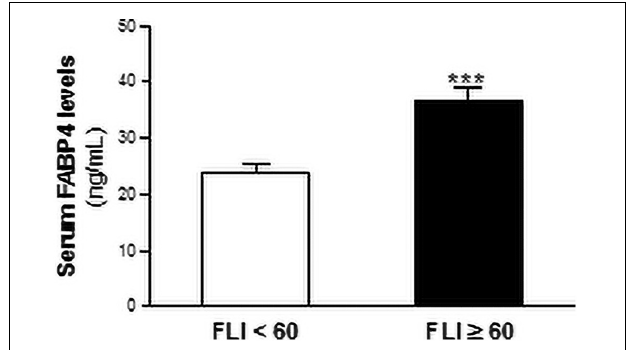
FIGURE 2 | Serum FABP4 levels are increased in patients with liver steatosis. Serum FABP4 levels are shown in patients with FLI ≥ 60 (black bars, N = 247) or those with FLI < 60 (white bars, N = 140). Data are expressed as the means ± SEM. ***P < 0.001 vs FLI < 60